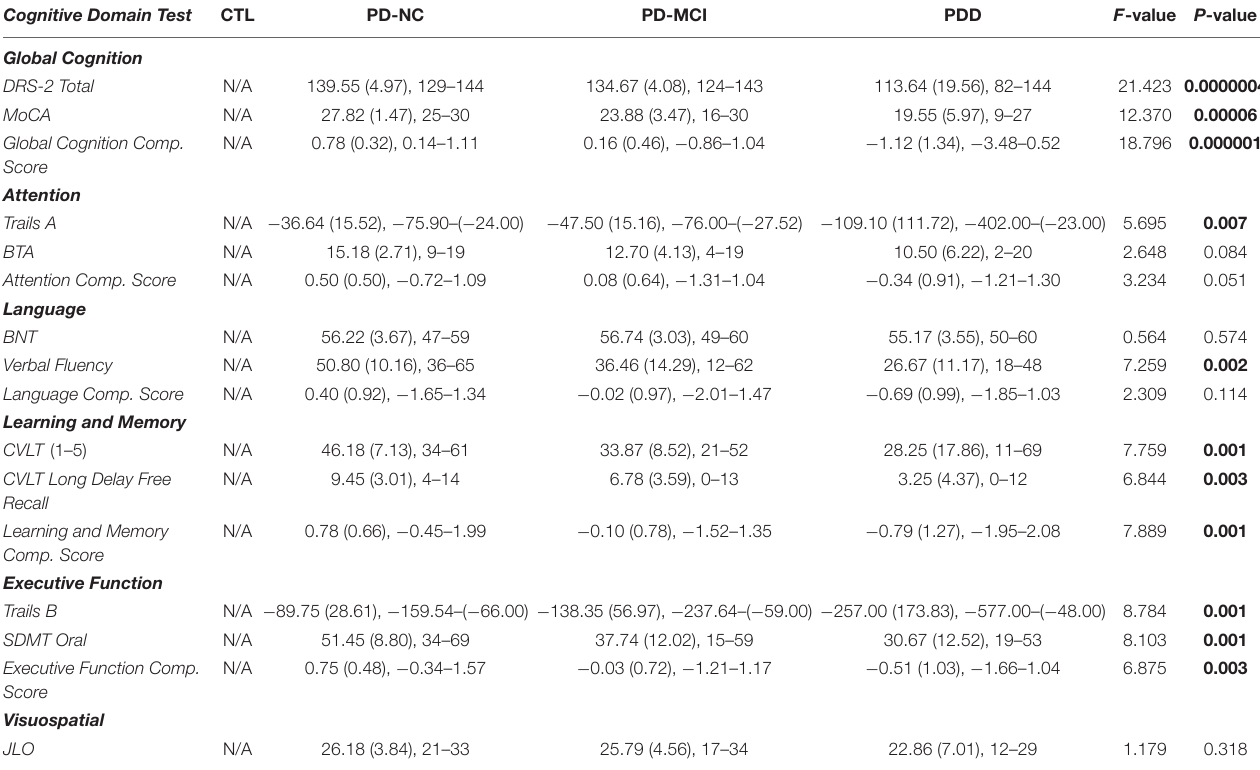
TABLE 1 | Neuropsychological test scores by cognitive classification for the PD groups. Cognitive Domain